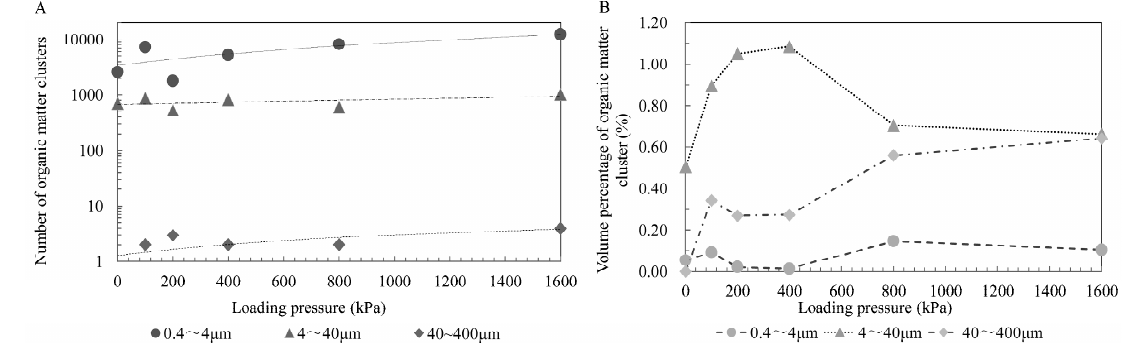
Figure 3. Variation of organic clusters with loading pressure. ( A ) The number of organic clusters varies with loading pressure; ( B ) the volume of organic clusters varies with loading pressure.